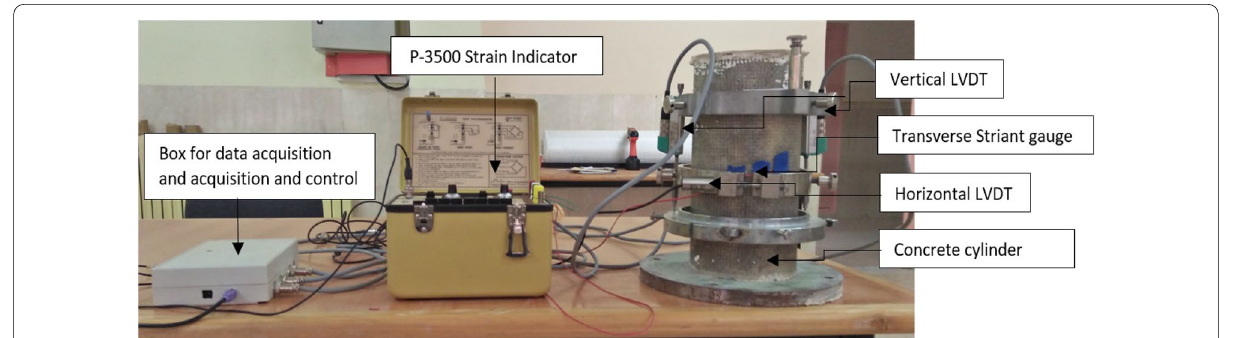
Fig. 4 Experimental setup and data acquisition system for compression concrete testing of a concrete cylinder